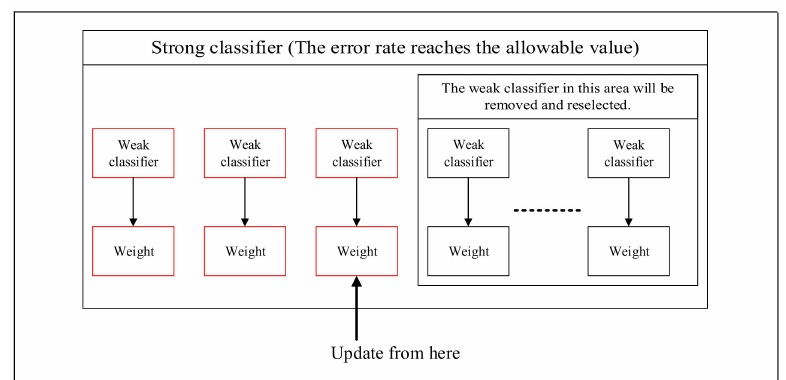
Figure 17. Method of deriving the strong classifier, whose error rate is lower than the allowable value.